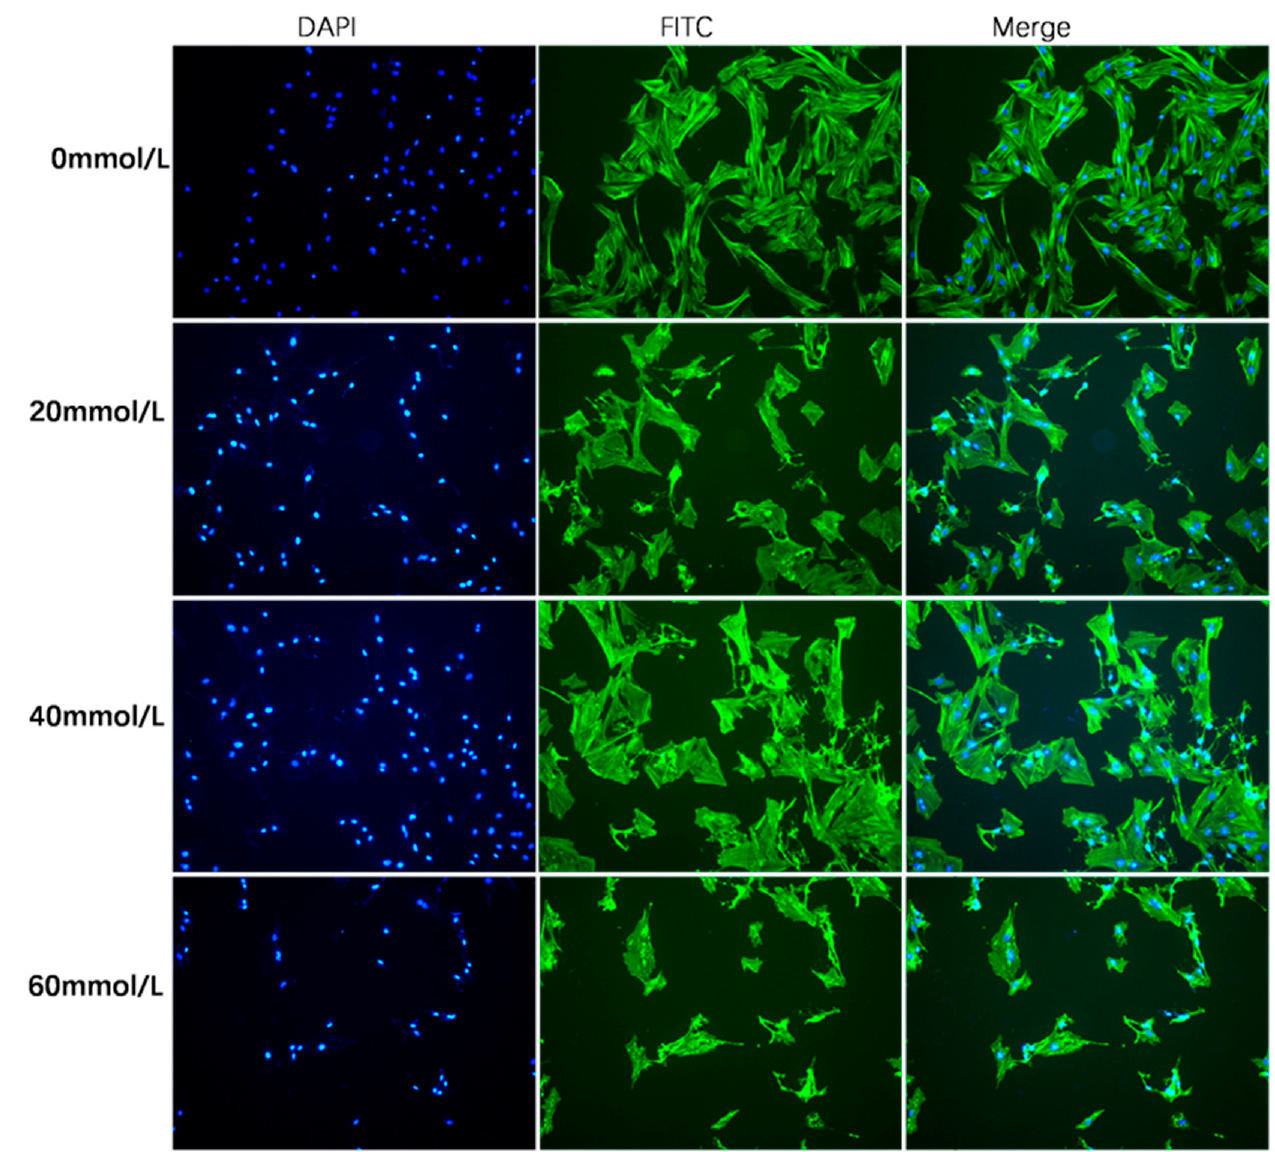
Figure 2. Cytoskeleton morphology image from fluorescence microscopy. Laser scanning confocal microscopy was used to observe the granulosa cells of the porcine ovary. Using the fluorescence immunocytochemistry method, cells were stained with various doses of 2,5-HD (0 mmol/L, 20 mmol/L, 40 mmol/L and 60 mmol/L) for 24 h. Scale bar 200µm.